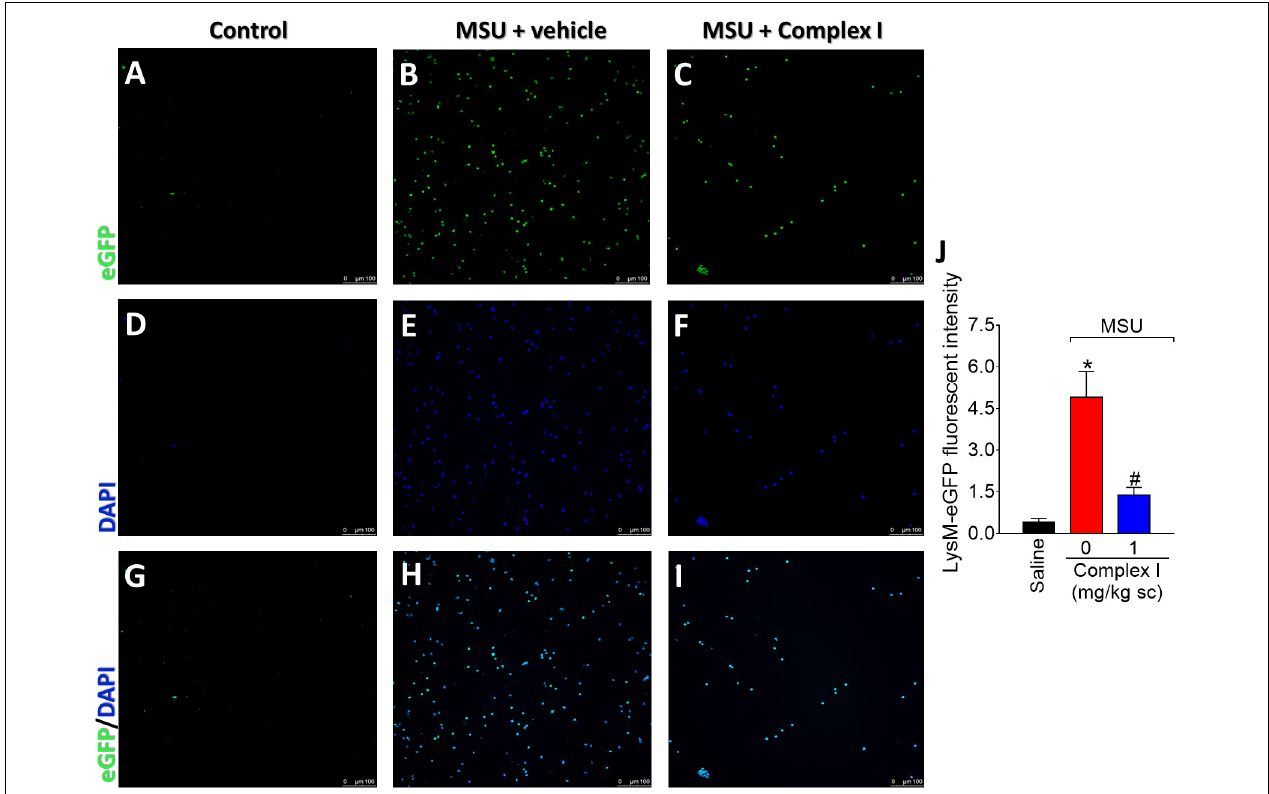
FIGURE 3 | Complex I inhibits MSU-induced neutrophil recruitment to the knee joint. Lysm-eGFP + mice were treated with complex I (1 mg/kg/saline, s.c.) or vehicle 30 min prior to intra-articular stimulation with MSU (100 µ g/10 µ l) and after 15 h synovial fluid was collected to evaluate the cellular migration (fluorescence intensity). (A–I) Show representative images of articular washes of control (A,D,G) , MSU + vehicle (B,E,H) and MSU + complex I 1 mg/kg (C,F,I) and (J) shows the mean ± SEM of fluorescence intensity in arbitrary units. Results are expressed as mean ± SEM ( n = 6 per group per experiment, representative of two